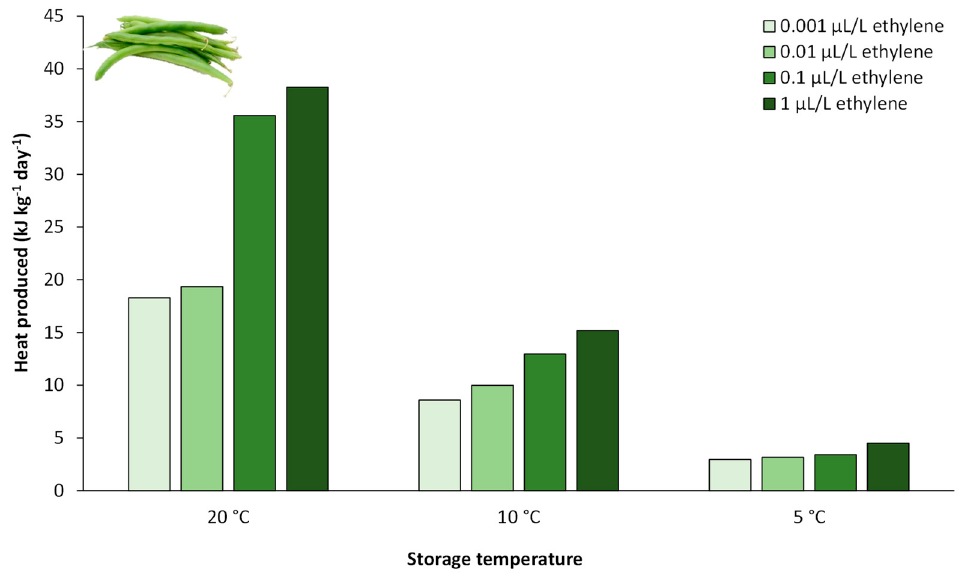
Figure 7. Heat production from the respiration of green beans after 4 days stored under different ethylene concentrations and temperatures (heat production is calculated according to Equation (1) and from data published by Lie et al. [11]).